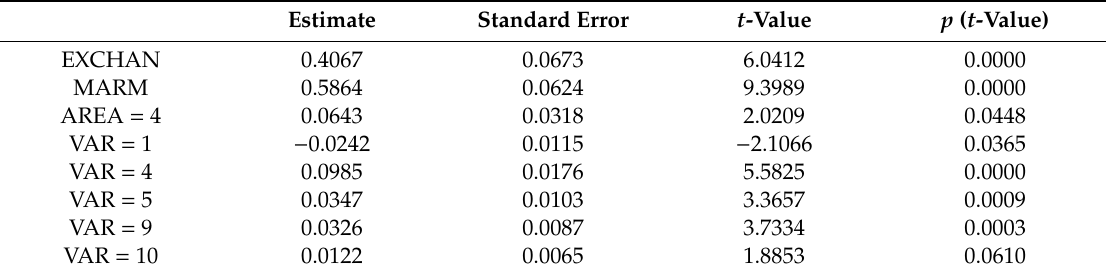
Table A7. Regression coe ffi cients for the model of the field prices of mandarins without considering the time (MONTH)